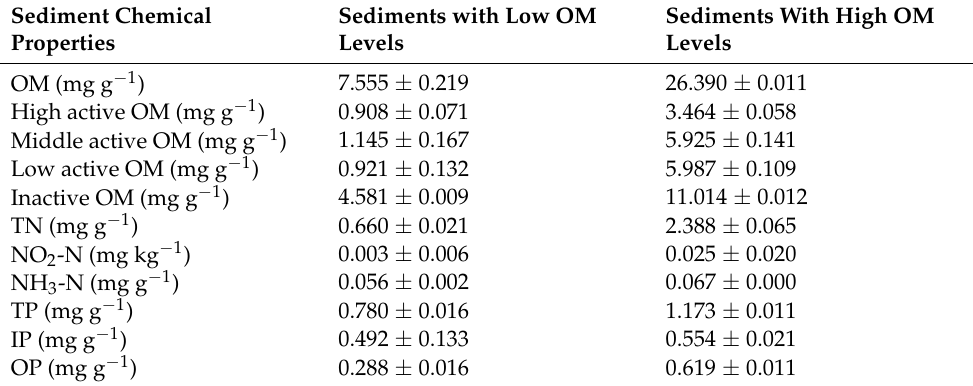
Table 2. Chemical properties of the sediment obtained from Maojiabu (sediments with low organic matter levels) and Xilihu (sediments with high organic matter levels), the two different areas of West Lake, Hangzhou, China. Organic matter (OM); Total nitrogen (TN); Nitrite nitrogen (TN); Ammonium nitrogen (NH 3 -N); Total phosphorus (TP); Inorganic phosphorus (IP); Organic phosphorus